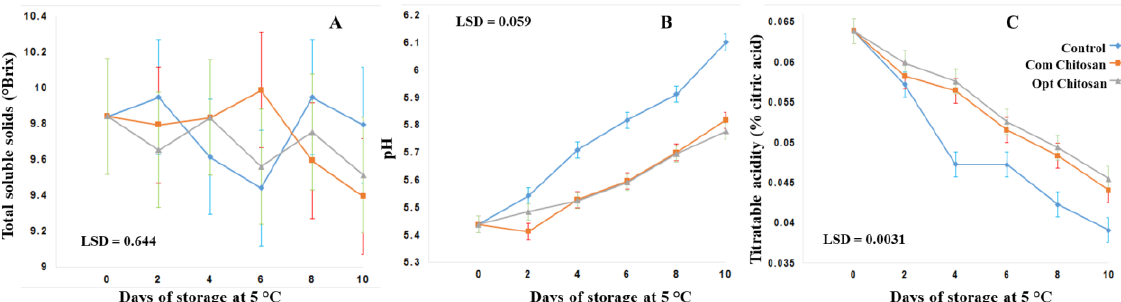
Figure 6. Changes in pH ( A ), total soluble solids ( B ) and titratable acidity ( C ) during storage at 5 °C of papaya slices previously dipped in a chitosan solution. Control = fresh-cut papaya slices without application of chitosan film; Quit Com = fresh-cut papaya slices with application of commercial chitosan film; Quit Opt = fresh-cut papaya slices with application of chitosan film obtained under optimized lactic fermentation conditions. Each point represents the mean of 15 replicates. Vertical bars indicate LSD ( p ≤ 0.05).